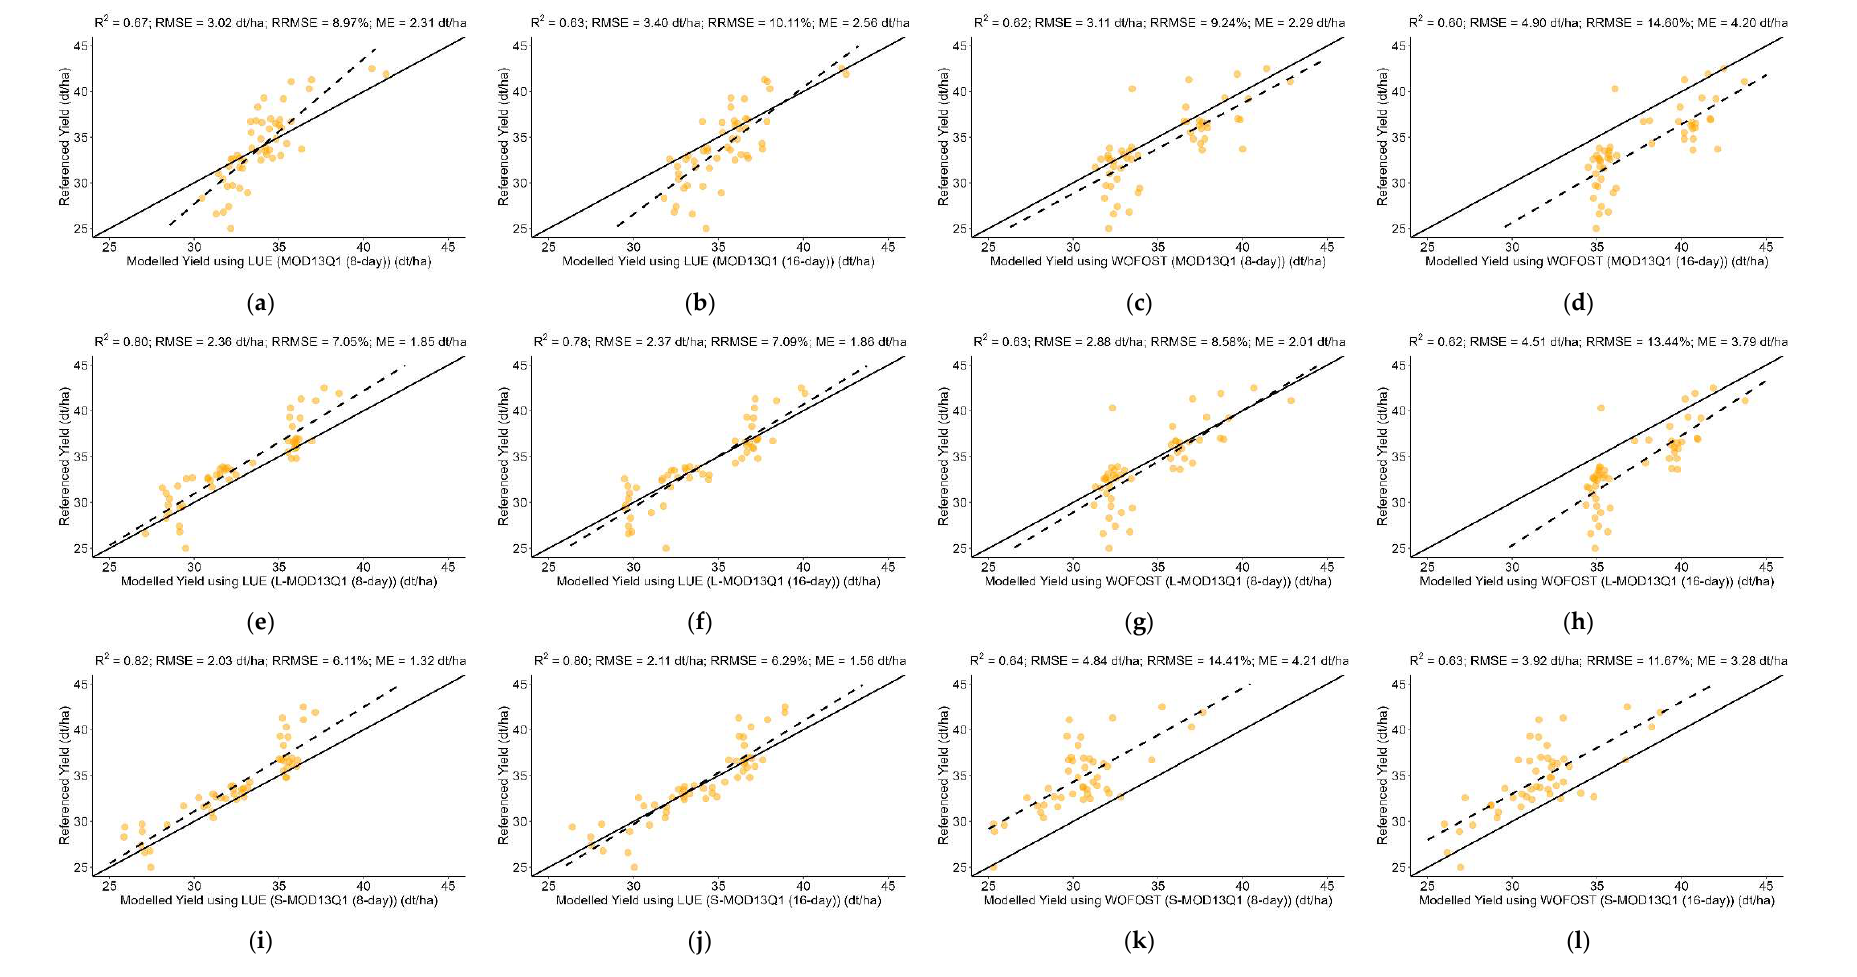
Figure 7 . The scatter plots ( a – l ) compare the accuracies of LUE- and WOFOST-modelled yields (inputting the 8- and 16-day MOD13Q1, L-MOD13Q1, and S-MOD13Q1) with the referenced yield of OSR. The orange dots represent OSR. Every plot contains a solid line to visualise the correlation of pixels between the referenced and modelled yield values.